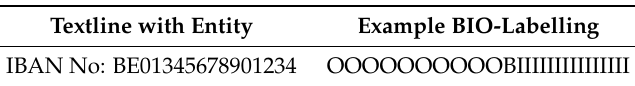
Table 2. An example of a BIO-tagged named entity.